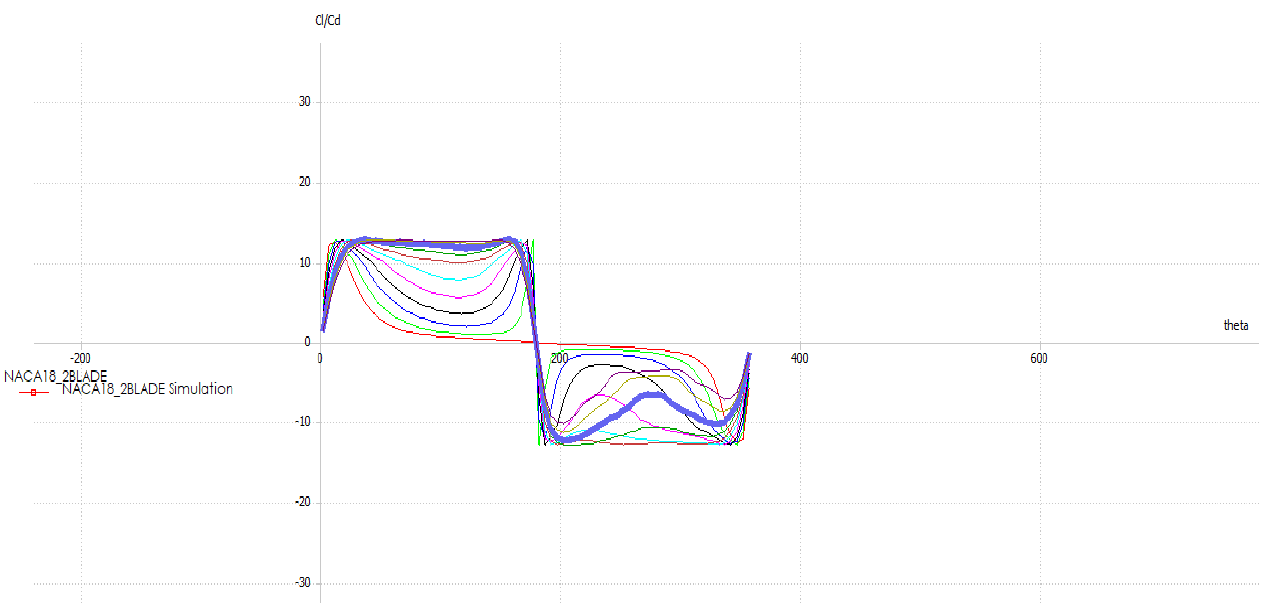
Figure 17. Cl/Cd vs theta plot of mid-section for TSR